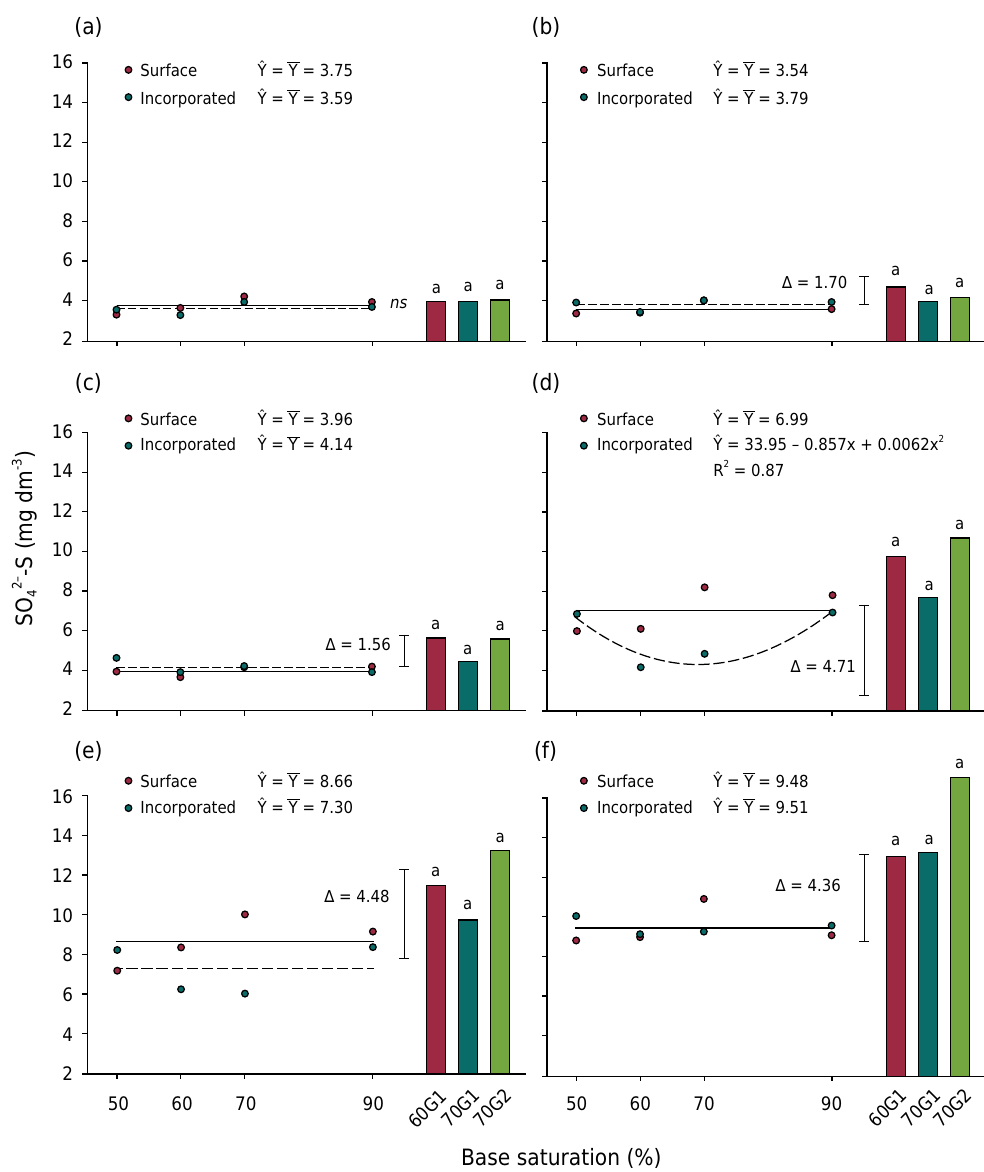
Figure 7. Sulfate (SO 42- -S) content in the 0.00-0.05 (a), 0.05-0.10 (b), 0.10-0.20 (c), 0.20-0.30 (d), 0.30-0.40 (e), and 0.40-0.60 m (f) layers at 48 months after treatment. Soils were limed to different base saturation (BS) levels (50, 60, 70, and 90 %) by surface application (SL) or lime incorporation (IL) or treated by surface application of lime (60 and 70 % BS) and a standard (G 1 ) or double (G 2 ) dose of phosphogypsum as 60G1, 70G1, and 70G2. Different letters above columns indicate significant differences between phosphogypsum treatments (Tukey’s test, p<0.05). Vertical bars represent least significant differences between treatments (Dunnett’s test,